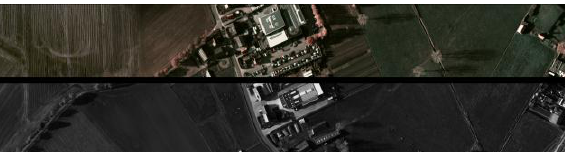
Figure 6 example image acquired with the MEDUSA CMOS sensor from an airborne flight. Top: colour image acquired with the RGB sensor, Bottom: image acquired with the panchromatic sensor.